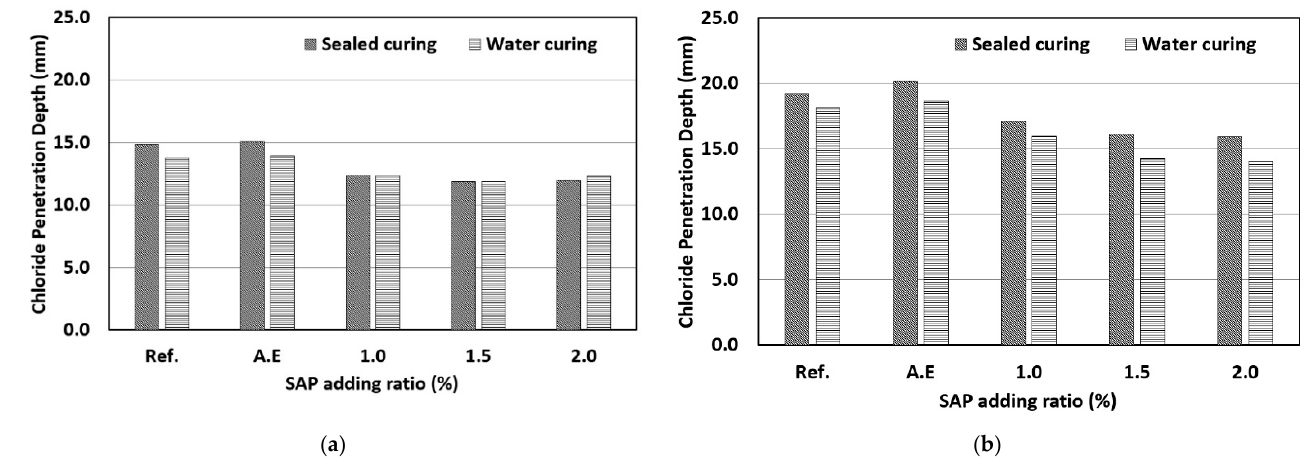
Figure 10. Results of chloride penetration depth: ( a ) Water–cement ratio 40%; ( b ) Water–cement ratio